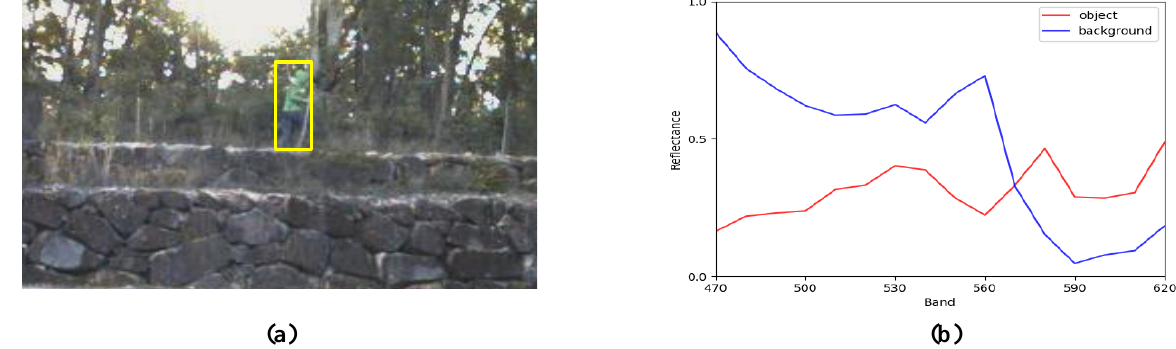
Figure 1. An example of the object and background colors are similar in the RGB image, but their spectral information is inconsistent. ( a ) shows the relationship between the object and the background in the RGB image, in which the object is marked with a yellow bounding box. ( b ) displays the spectral response curves of two pixels from the object and the background,